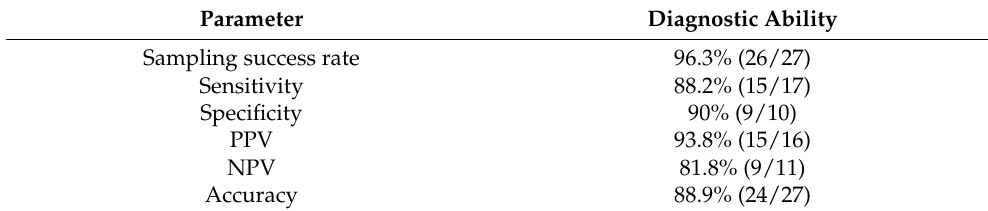
Abbreviations: PPV, positive predictive value; and NPV, negative predictive